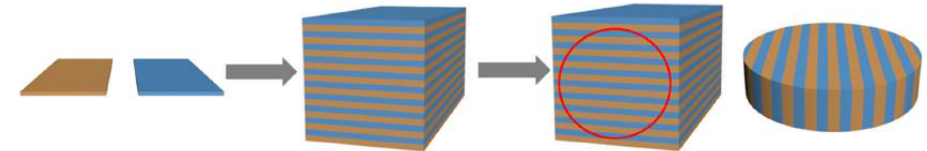
Figure 11. The schematic diagram preparing independent distributed dual-phase membranes [74].